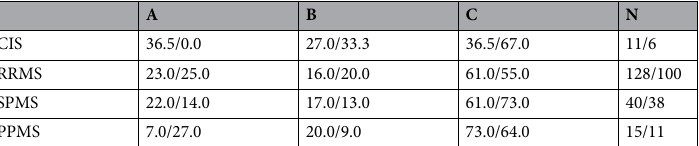
Table 3. Association between MS course type and willingness to take SARS-CoV-2 vaccine (percentage within course type groups at 1st follow-up/2nd follow-up). A—Certainly not or unlikely taking a SARS-CoV-2 vaccine; B—Not known yet; C—Probably or with certainty taking a SARS-CoV-2 vaccine; CIS clinically isolated syndrome, MS multiple sclerosis, PPMS Primary progressive MS, N total number of patients, RRMS relapsing–remitting MS, SPMS Secondary progressive MS. Meaning of percentages in a field − example field RRMS/A: 23.0% of RRMS-patients at the 1st follow-up and 25.0% at the 2nd follow-up were certainly not or unlikely taking a SARS-CoV-2